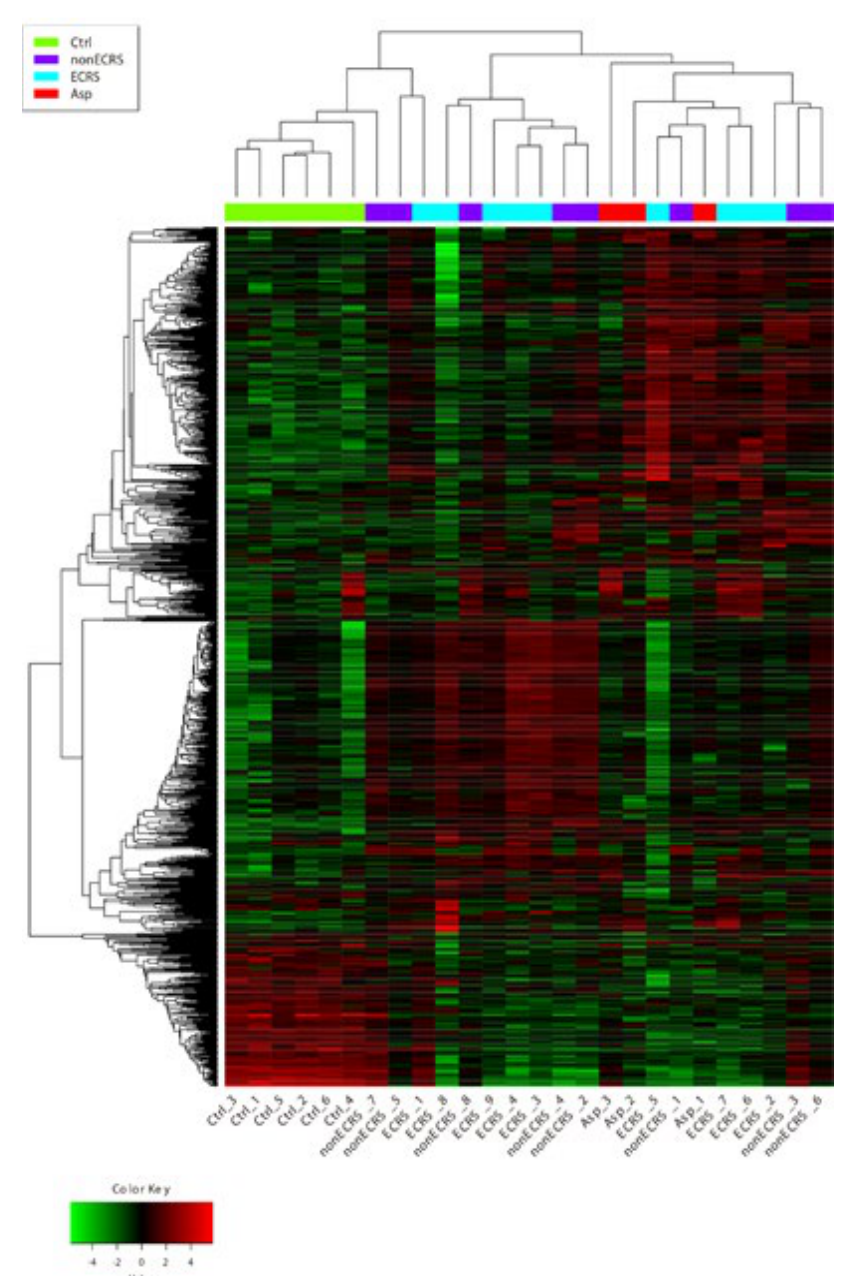
Figure 2. Hierarchical cluster analysis with cutoff Z score of 4. No distinct segregation among the three CRSwNP groups was seen and some ECRS (ECRS1) and nonECRS (nonECRS5 and 7) patients were in a similar cluster to the control group. However, a Venn diagram of all CRSwNP groups vs control showed the existence of specific DEGs in each CRSwNP group (Figure